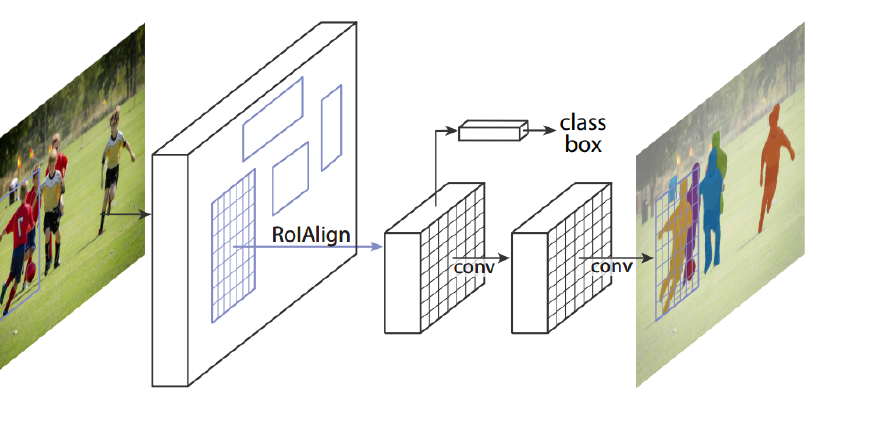
Figure 13. The explained architecture of Mask R-CNN [25]. The architecture of Mask R-CNN extends the architecture of Faster R-CNN [23] with two modifications: (1) replacing the RoI pooling with RoIAlign layer; (2) addition of segmentation branch along with regression and classification. Reprinted from